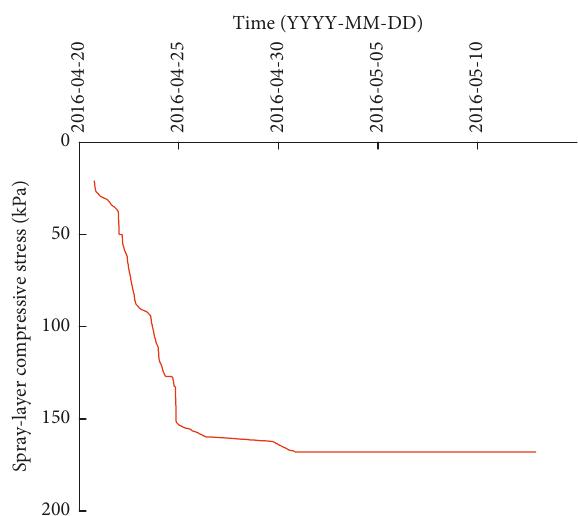
Figure 12: Spray pressure stress-time curve of the surrounding rock at the cross section of ZK52+560.